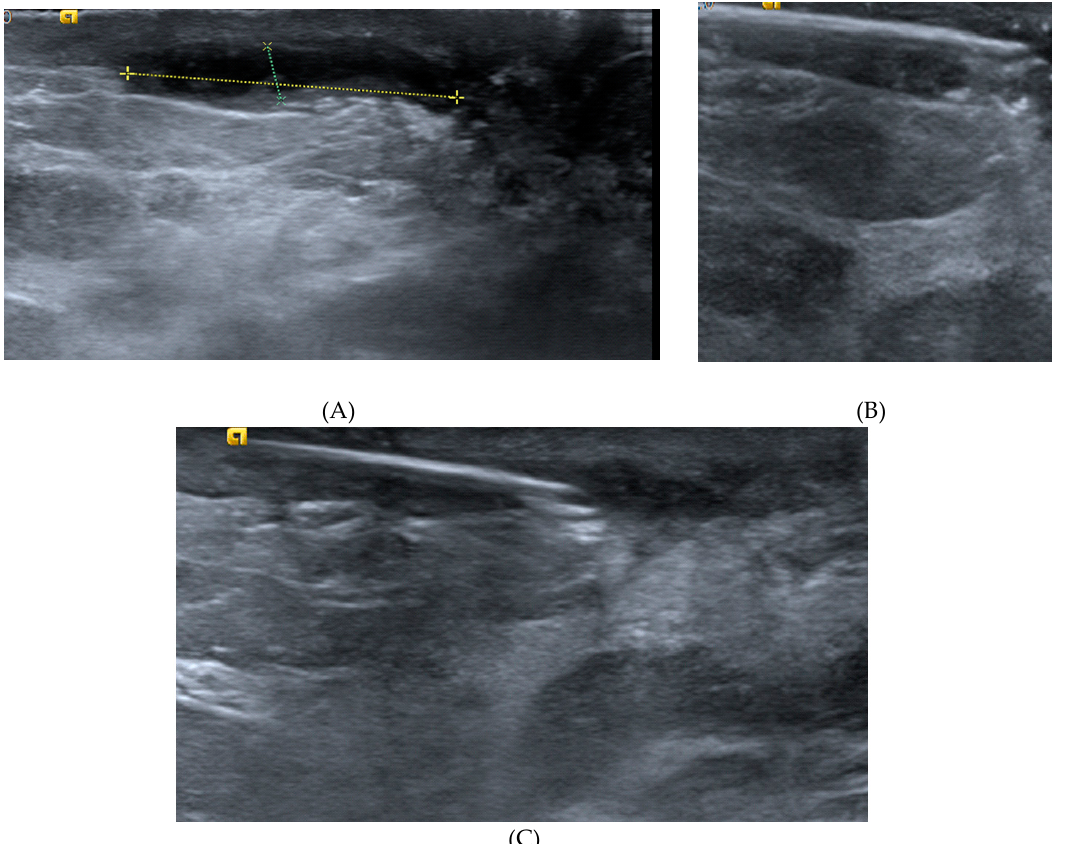
Figure 2. Example of PNE of an MF: ( A ) the ultrasound image shows a hypoechoic elongated appearance; ( B ) needle inserted into the track distal zone; ( C ) hyperechoic image over the needle after application of PNE.